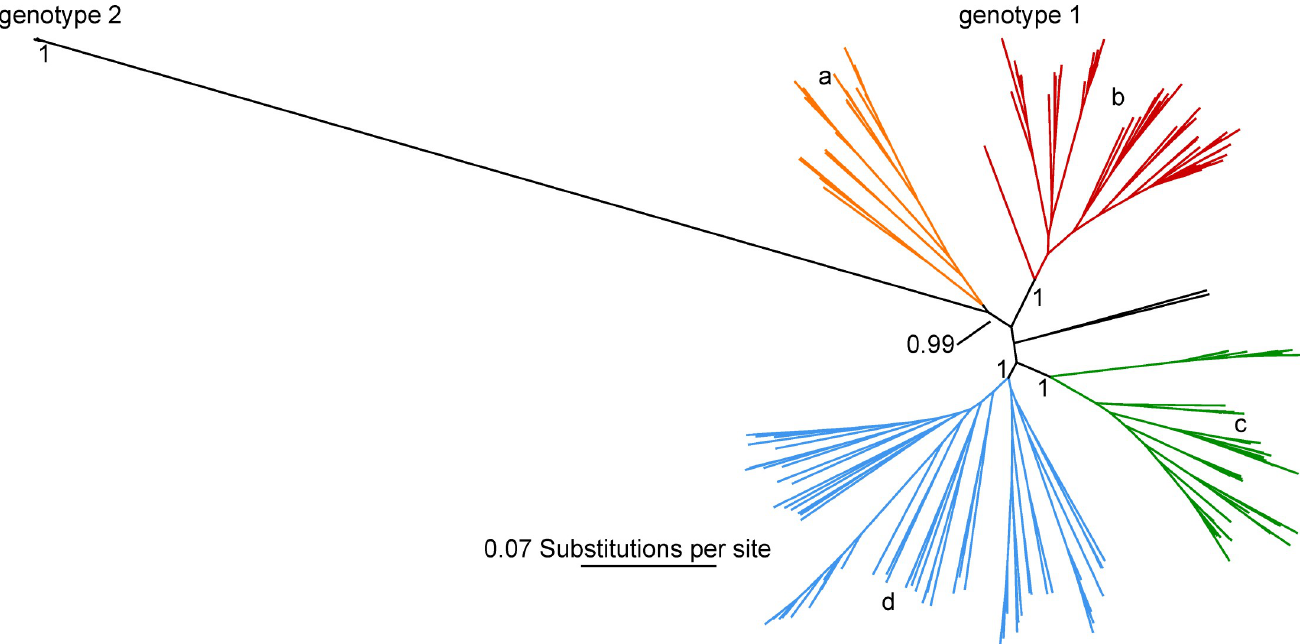
Fig 1. Approximate maximum likelihood unrooted tree of 246 M . bovoculi whole genome single nucleotide polymorphisms (SNP) profiles with Phi Pack identified recombination SNPs removed to increase node support within genotype 1. Four well supported subtypes of genotype 1(a-d) are color coded.